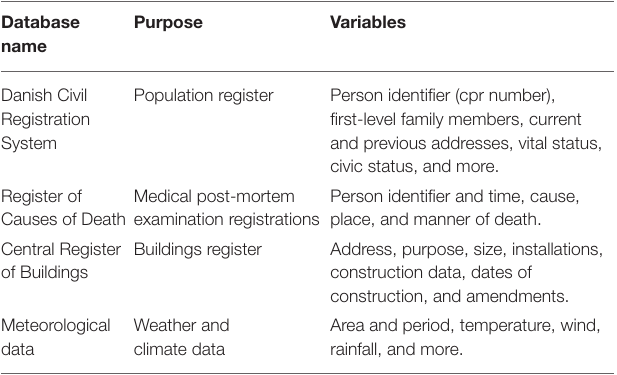
TABLE 5 | Selected administrative databases in Denmark with relevance for One Health surveillance or